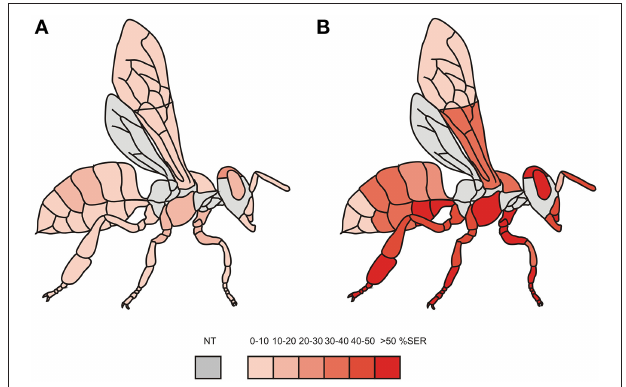
FIGURE 2 | Tactile and heat sensitivity maps obtained by measuring sting extension responses. The maps represent the percentage of SER observed after tactile (A) or thermal (B) stimulation of each structure of the bee body, using a color scale from light red (0–10% of SER) to dark red ( > 50% of SER). Gray areas were not accessible in our holding setups and were thus not tested (NT). Sting extensions are mainly due to thermal input as seen from the comparison of both